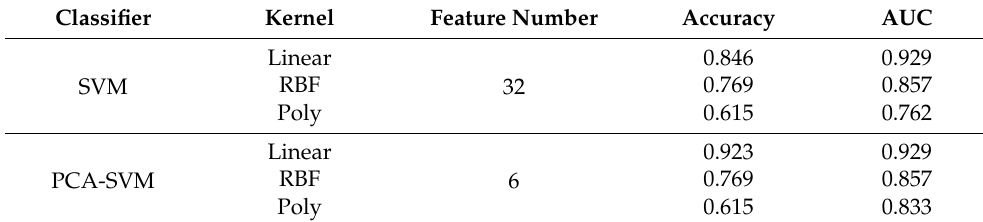
Table 3. Thirty-two parameter set to predict CDR-SB